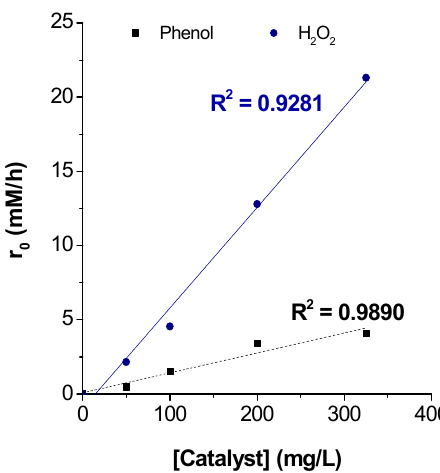
Figure 6. Effect of catalyst dose on the initial reaction rate of phenol oxidation and oxidant Figure6. E ff ectofcatalystdoseontheinitialreactionrateofphenoloxidationandoxidantdecomposition decomposition ([phenol] initial = 1.0 g/L, [H 2 O 2 ] initial = 1.44 g/L, T = 50 °C and pH initial = 4.0). Adapted ([phenol] initial = 1.0 g / L, [H 2 O 2 ] initial = 1.44 g / L, T = 50 ◦ C and pH initial = 4.0). Adapted from from Martín et al. [73]. Mart í n et al. [73].